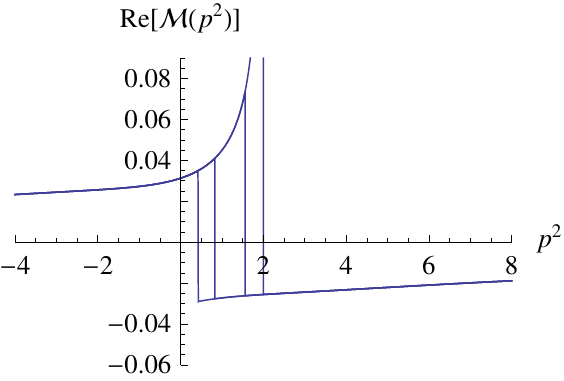
Figure 24 . Two-dimensions: numerical results from the nonanalytic Wick rotation with no domain deformation and comparison with the average